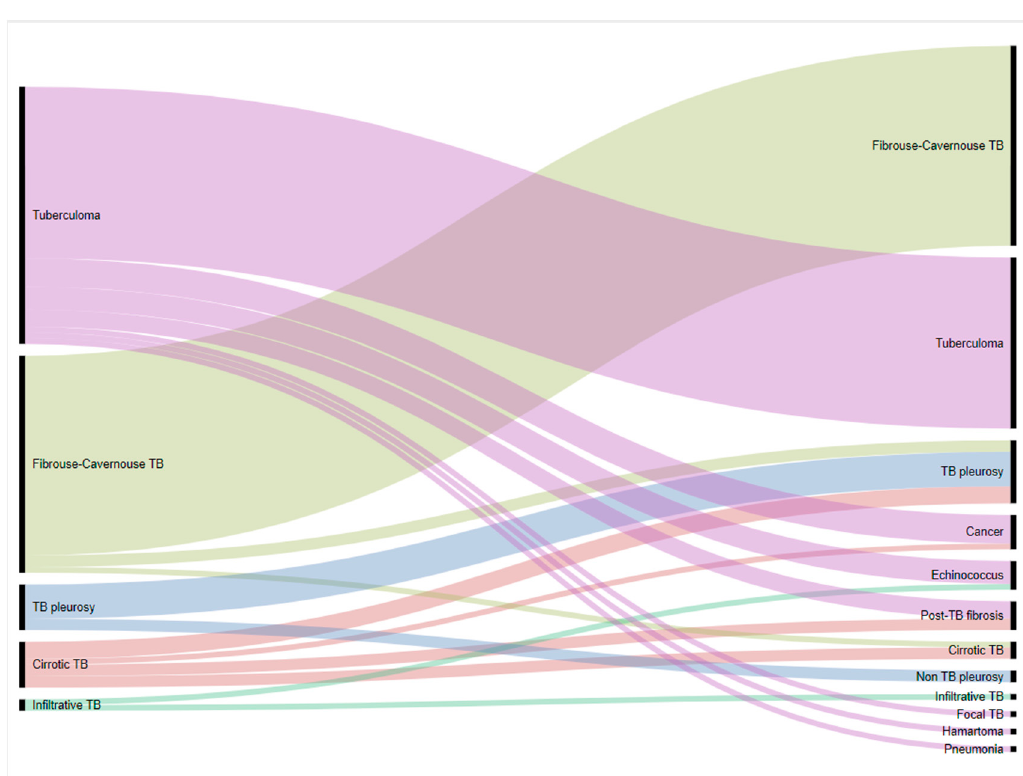
Figure 1. Alluvial plot illustrating the comparison of histological diagnoses after surgery was performed with diagnoses before surgery among patients treated for respiratory tuberculosis who underwent adjunctive surgery at RSSPMCPP in Uzbekistan from January to May 2017 ( n = 101). RSSPMCPP—Republican Specialized Scientific-Practical Medical Centre of Phthisiology and Pulmonology; TB—tuberculosis.